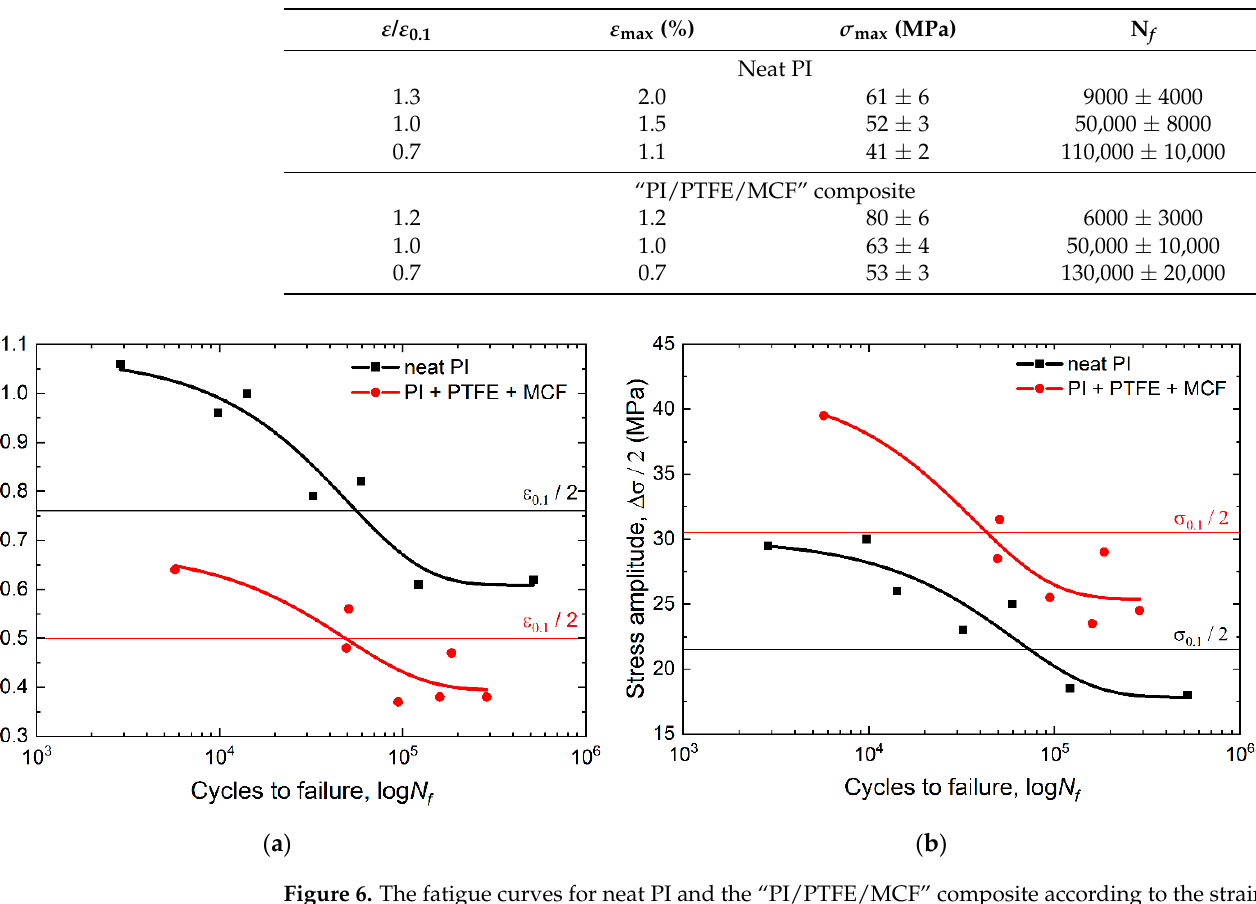
Table 2. The results of the fatigue tests for neat PI and the “PI/PTFE/MCF” composite. ε / ε 0.1